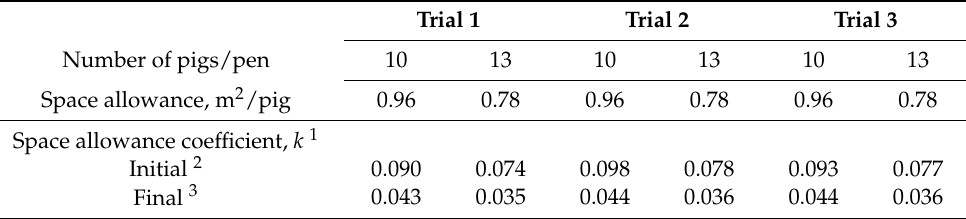
Table 2. Initial and final space allowance coefficient ( k ) for each treatment in trial 1, 2 and